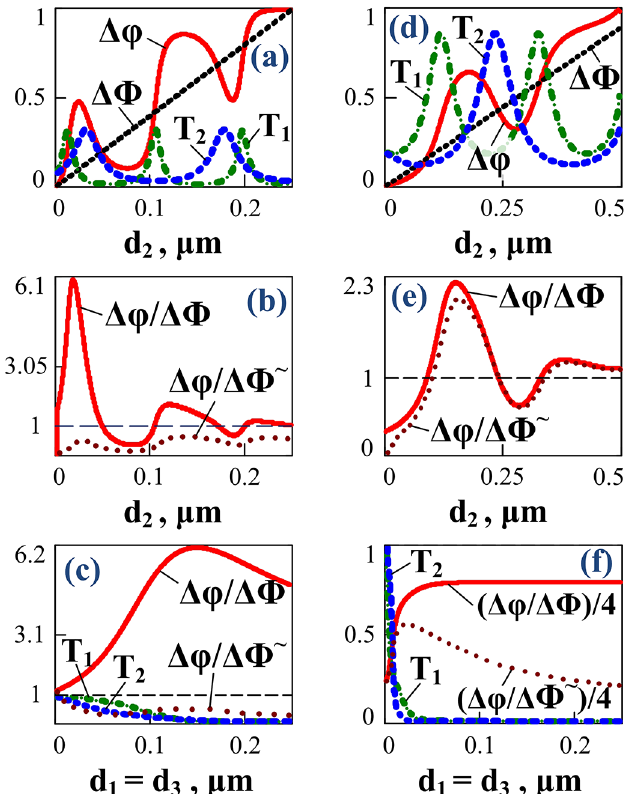
Fig. 7. Dependences of PSD D ’ , DF , relations D ’ / DF , D ’ / DF ∼ and energy transmission coef fi cients T 1,2 of waves 1, 2 on thicknesses d 2 (a, b, d, e), d 1,3 (c, f) for silver layers 1, 3 and two different wavelengths of the incident wave. The values of the Ag permittivity for l = 292nm (a, b, c), 650nm (d, e, f) are given in the text. The values of parameters are: d 1,3 = 125nm (a, b), 9 nm (d, e); d 2 = 19nm (c), 171nm (f). Figures b and e detail the data in fi gures a and d, respectively. The black horizontal dashed line in fi gures b, c, e characterizes equality to 1 of the corresponding